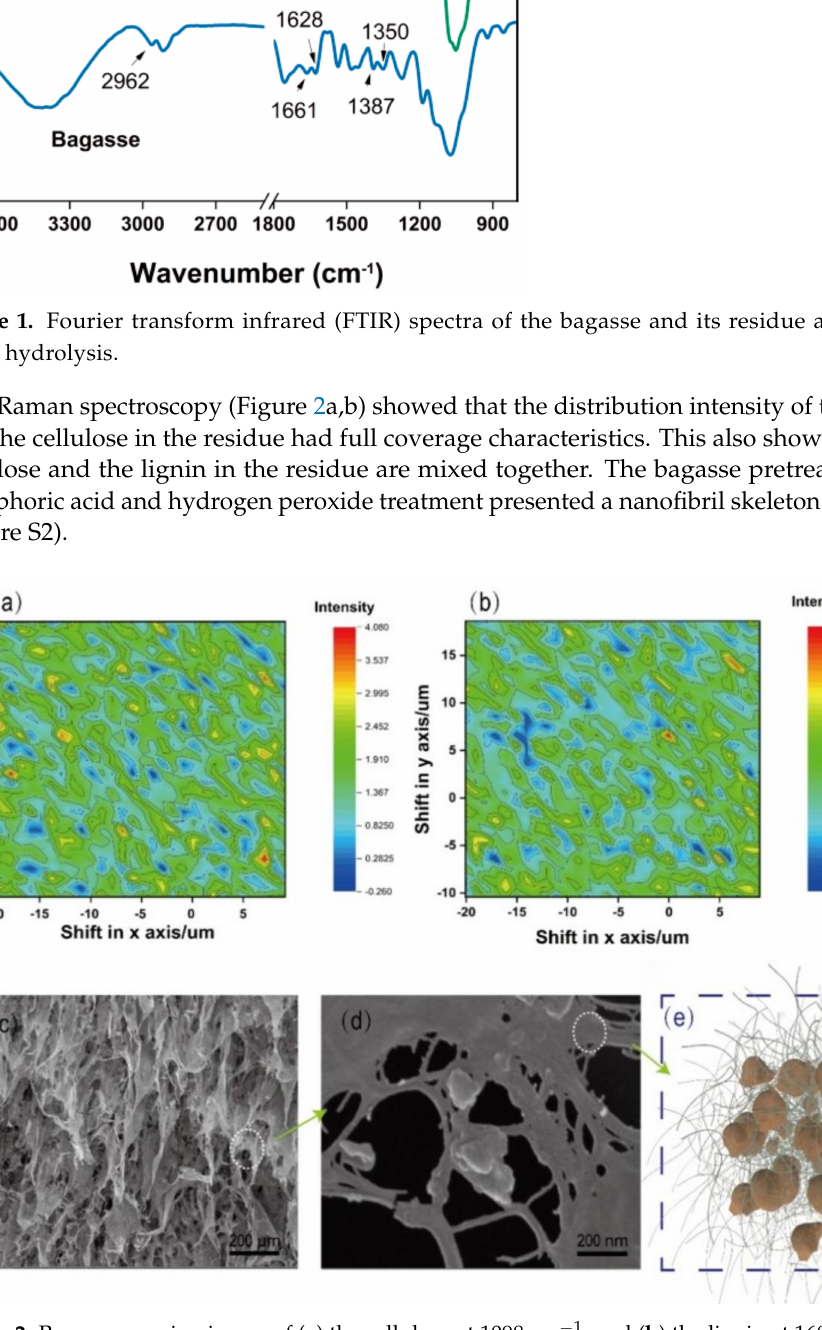
Figure 2. Raman mapping image of ( a ) the cellulose at 1098 cm − 1 , and ( b ) the lignin at 1600 cm − 1 in the bagasse remaining after enzymatic hydrolysis; ( c , d ) SEM images of the residue after enzymatic hydrolysis; ( e ) schematic diagram of the nanocellulose hybrid lignin